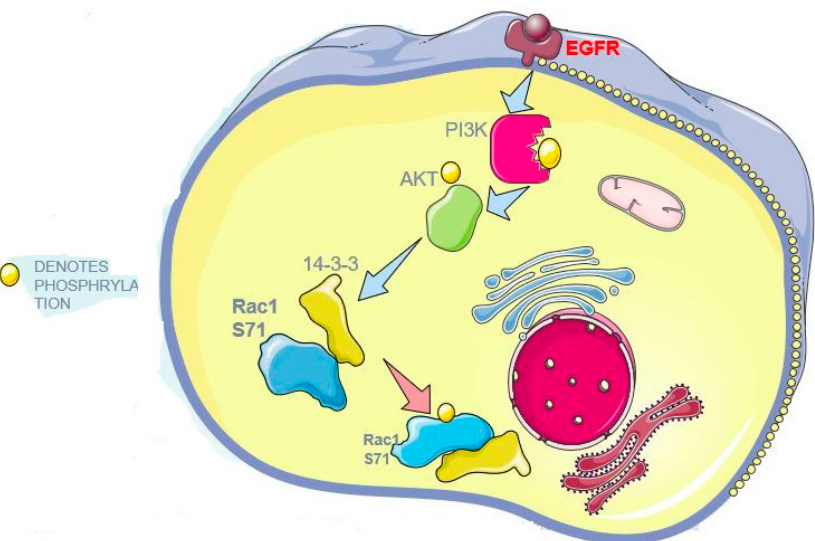
Figure 8. Diagram to depict the interaction between Rac1 and 14-3-3s.